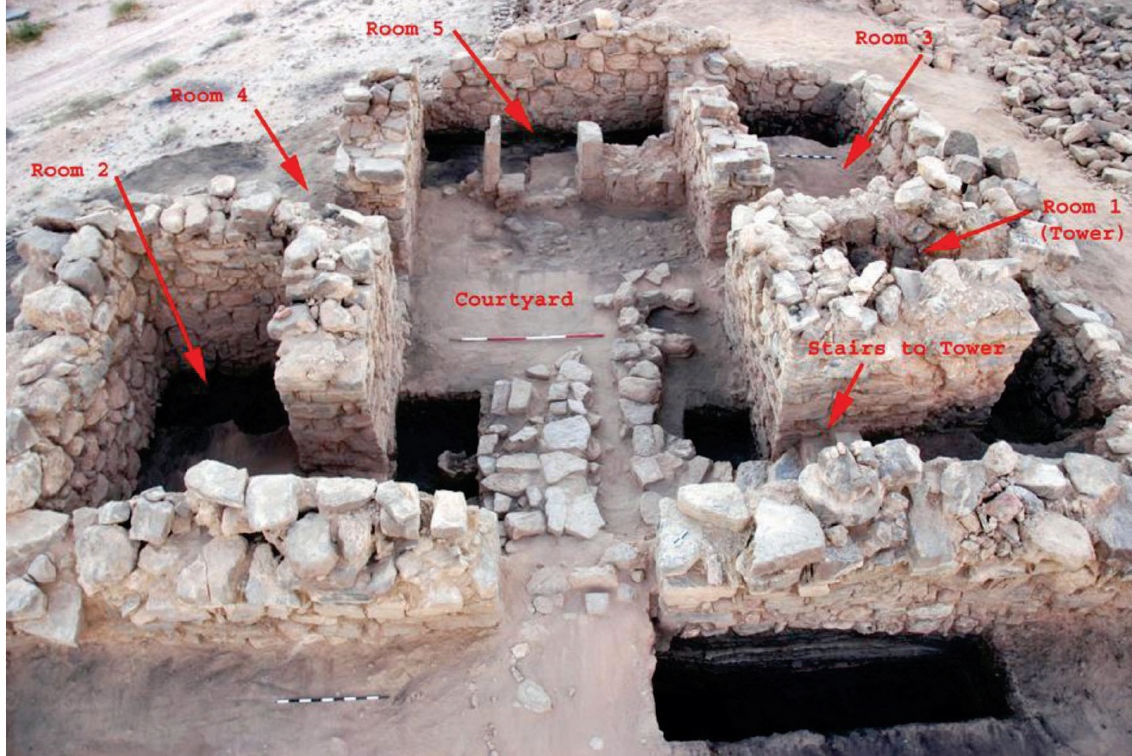
Figure 9. The 2006 Khirbat en-Nahas excavation - Area T. (Source: Levy et al.